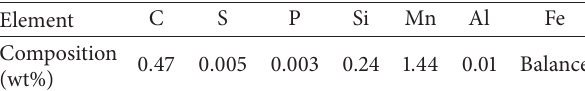
Table 1: Chemical composition of pipeline steel (wt%). Element C S P Si Mn Al Fe Composition 0.47 0.005 0.003 0.24 1.44 0.01 Balance (wt%)